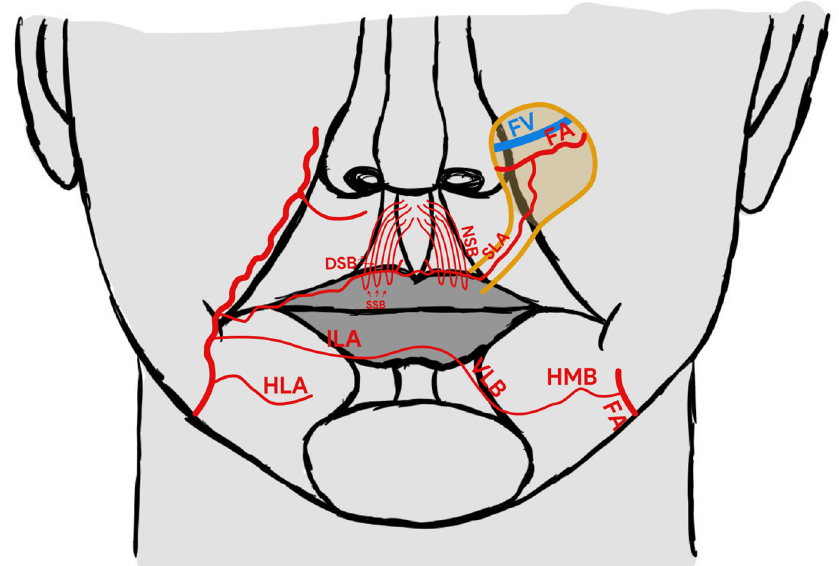
Figure 2. rSLA pedicle skin flap rotation into the donor site. FA—facial artery, FV—facial vein, SLA—superior labial artery, SLV—superior labial vein, ILA—inferior labial artery, HLA—horizontal labiomental artery, HMB—horizontal mental branch, VLB—Vertical labiomental branch, NSB—nasal septal branches, DSB—deep septal branch, SSB—superficial septal branch.